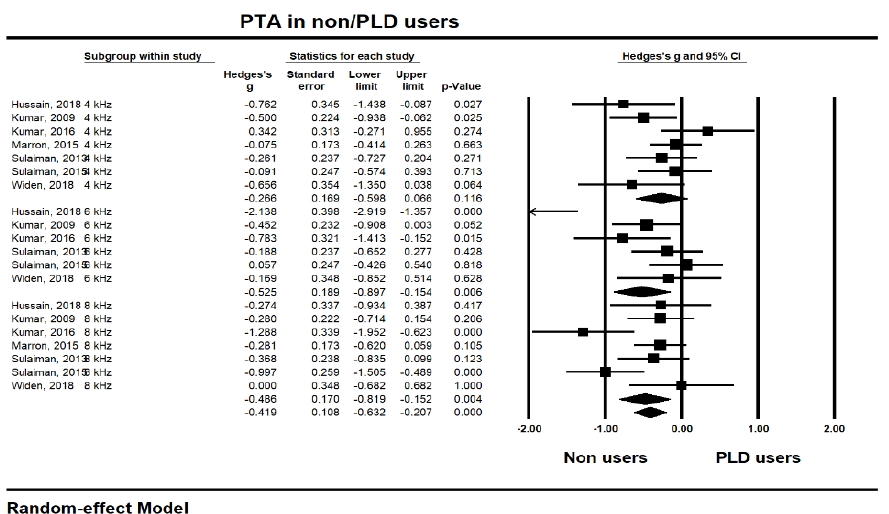
Figure 4. Long-term hearing changes of pure tone audiometry (PTA) thresholds at 4, 6, and 8 kHz after music exposure.